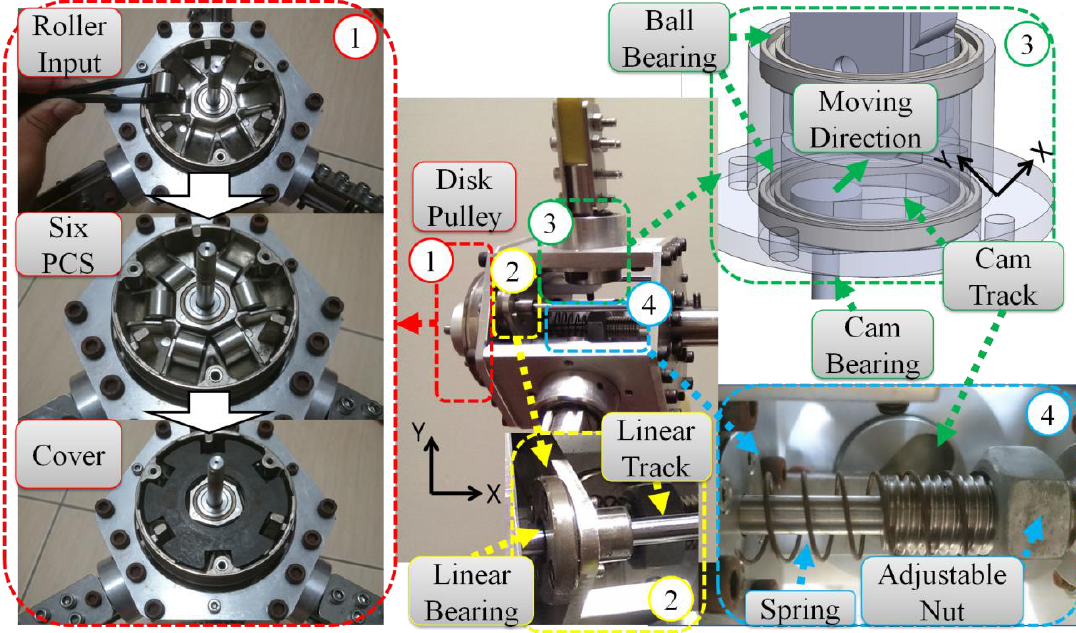
Figure 10. Regional components of the PPC system.